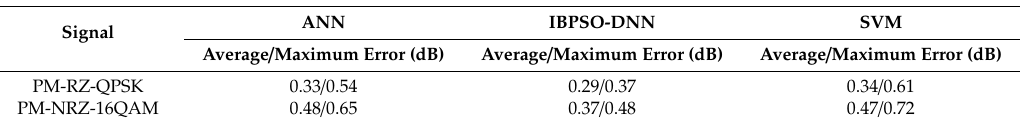
Figure 12. Average estimated errors for ( a ) PM-RZ-QPSK signal and ( b ) PM-NRZ-16QAM signal processed by artificial neural network (ANN), improved binary particle swarm optimization and deep neural network (IBPSO-DNN), and support vector machine (SVM). Table 1. The average and maximum estimated errors of PM-RZ-QPSK and PM-NRZ-16QAM signals using ANN, IBPSO-DNN, and SVM.